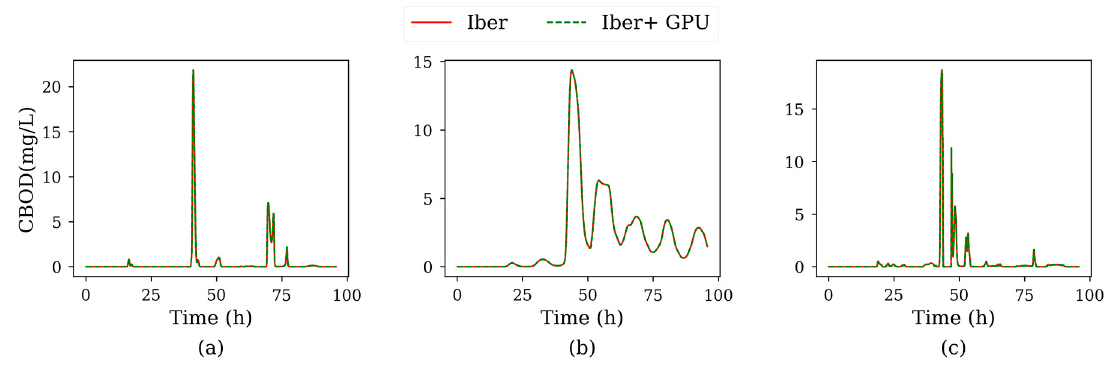
Figure 7. Time series of carbonaceous biochemical oxygen demand (CBOD) for Test 2 at control points P1 ( a ), P2 ( b ) and P3 ( c ).